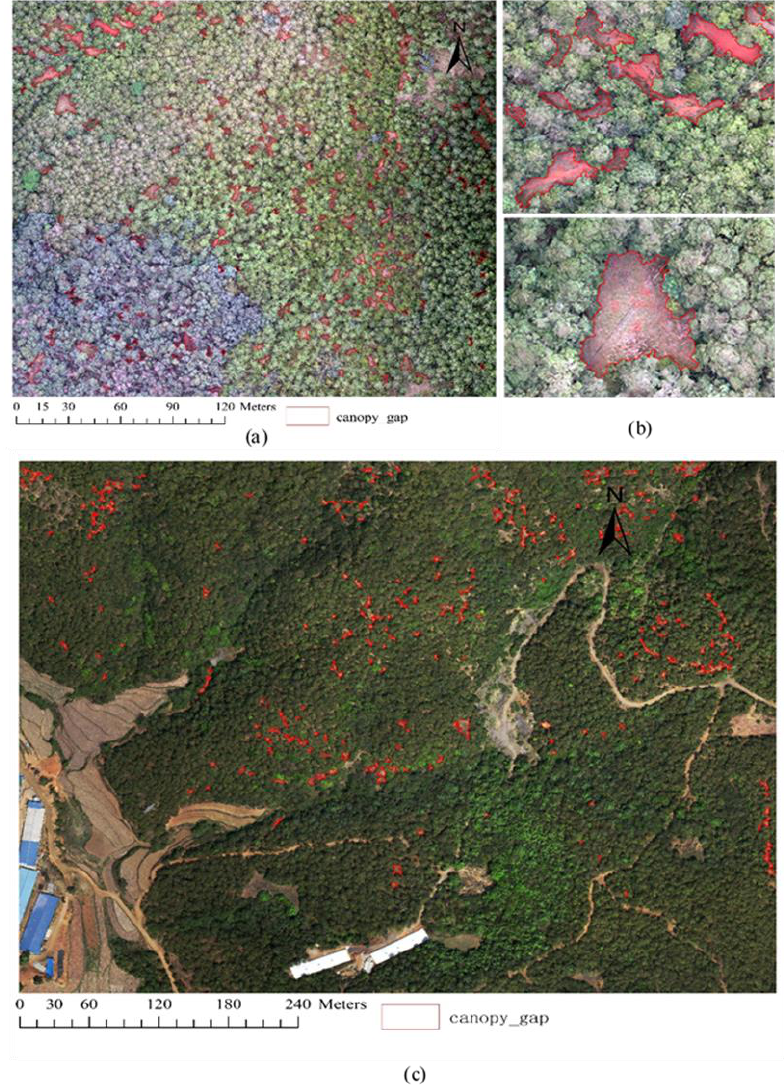
Figure 8. Distribution of canopy gaps in study area I ( a ) and study area II ( c ), and local extraction results ( b ).